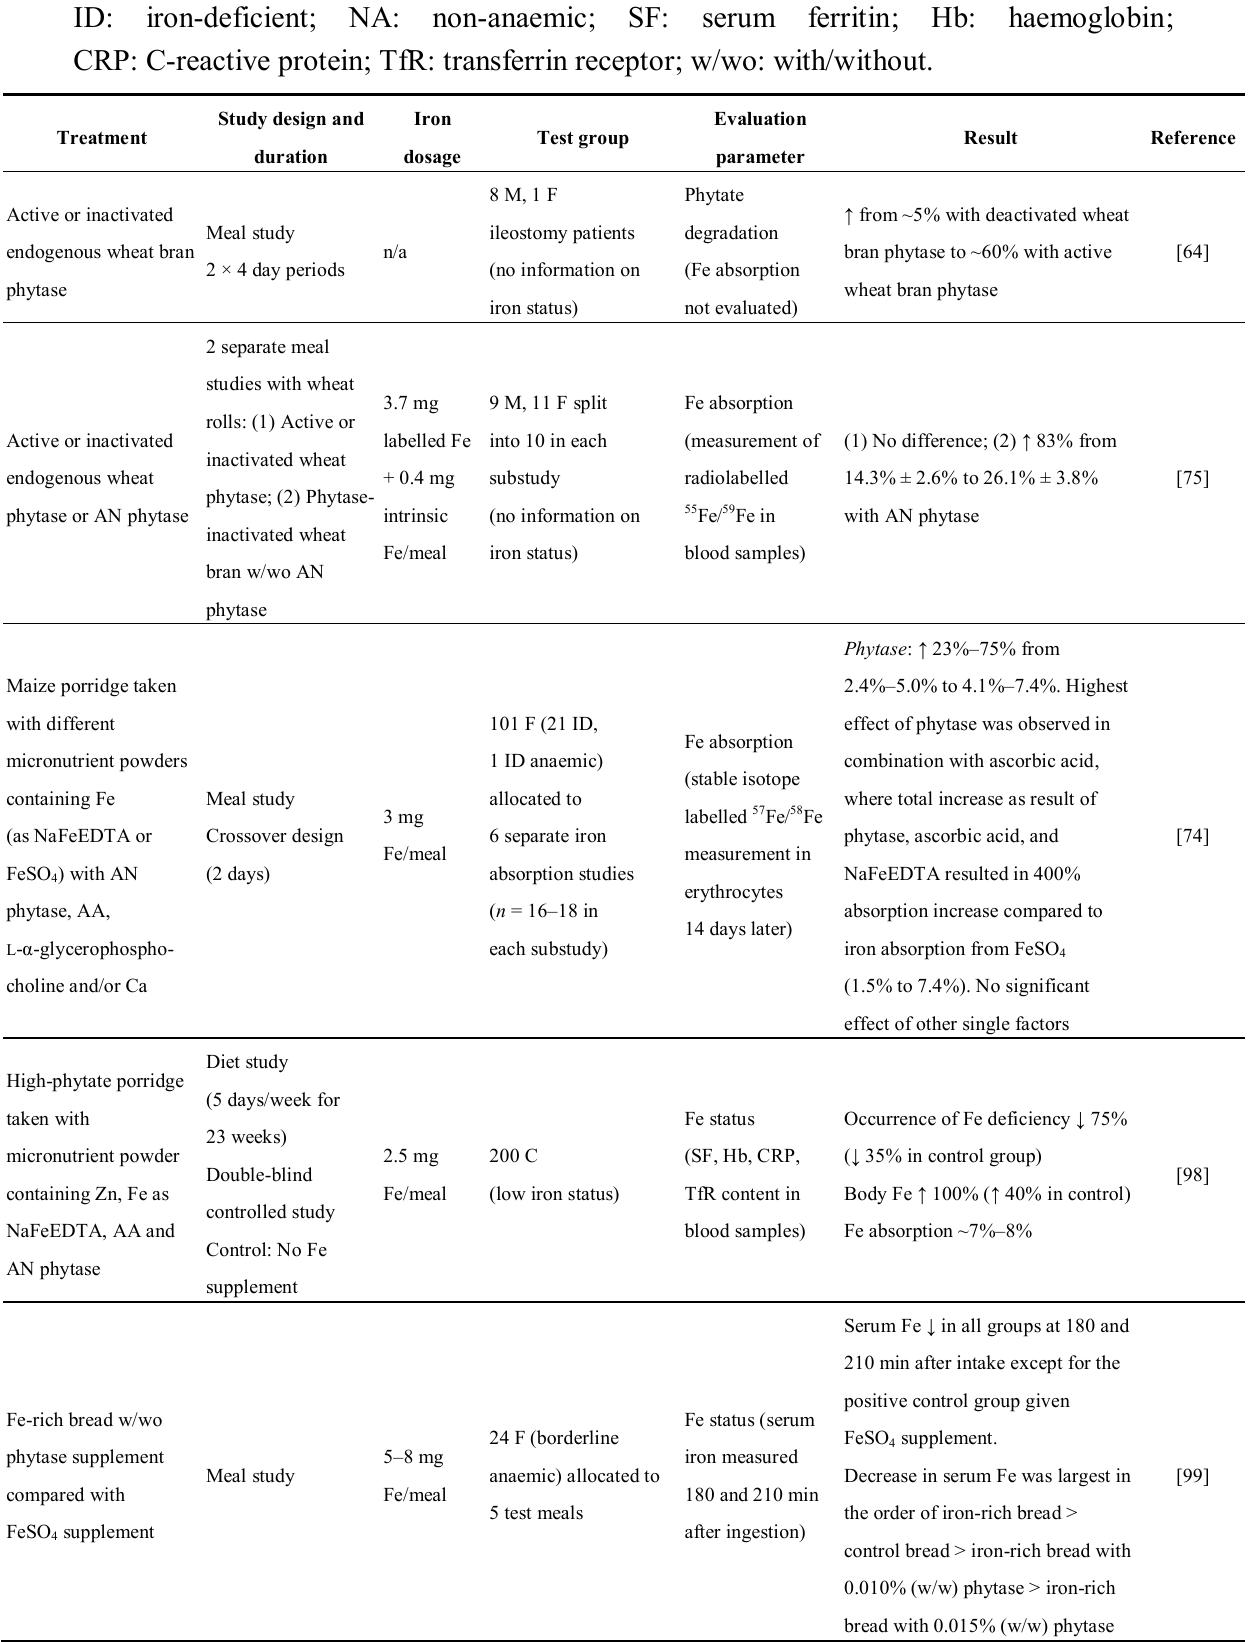
Table 2. Condensed results from in vivo phytase catalysis studies. Abbreviations: CA: citric acid; AA: ascorbic acid; AN: Aspergillus niger ; M: male; F: female; C: